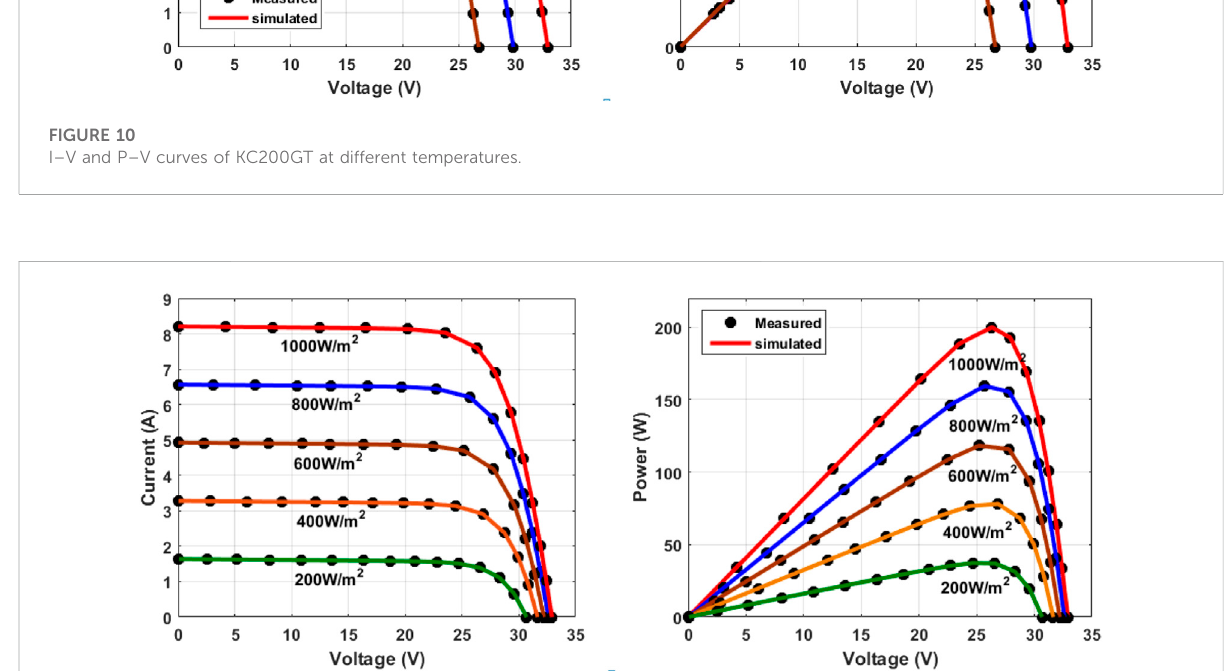
FIGURE 11 Measured and simulated I – V and P – V curves of KC200GT at different